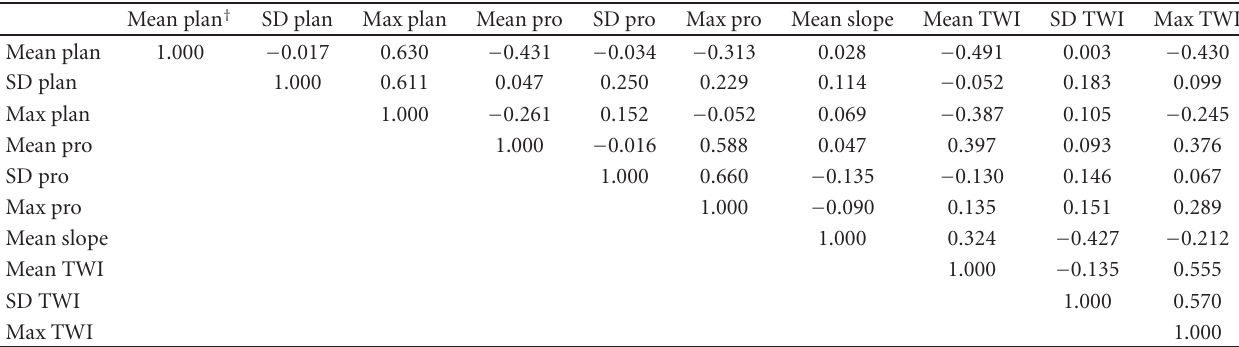
Table 2: Correlation matrix for ten topographic indices derived from 5m IFSAR digital terrain model. Variables were transformed to range between zero and one. Values are summarized from 36 pixels that occurred within a 30m × 30m Landsat image pixel.